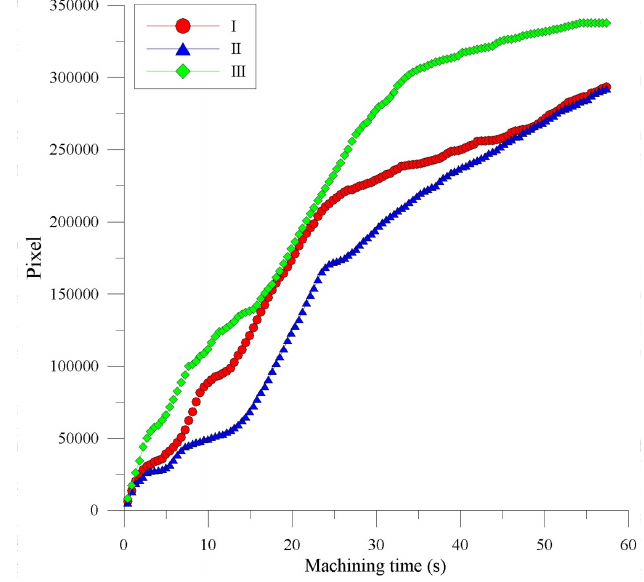
Figure 9. The accumulated light emission pixels of the SACE-drilled holes, acquired by using a radially mounted industrial